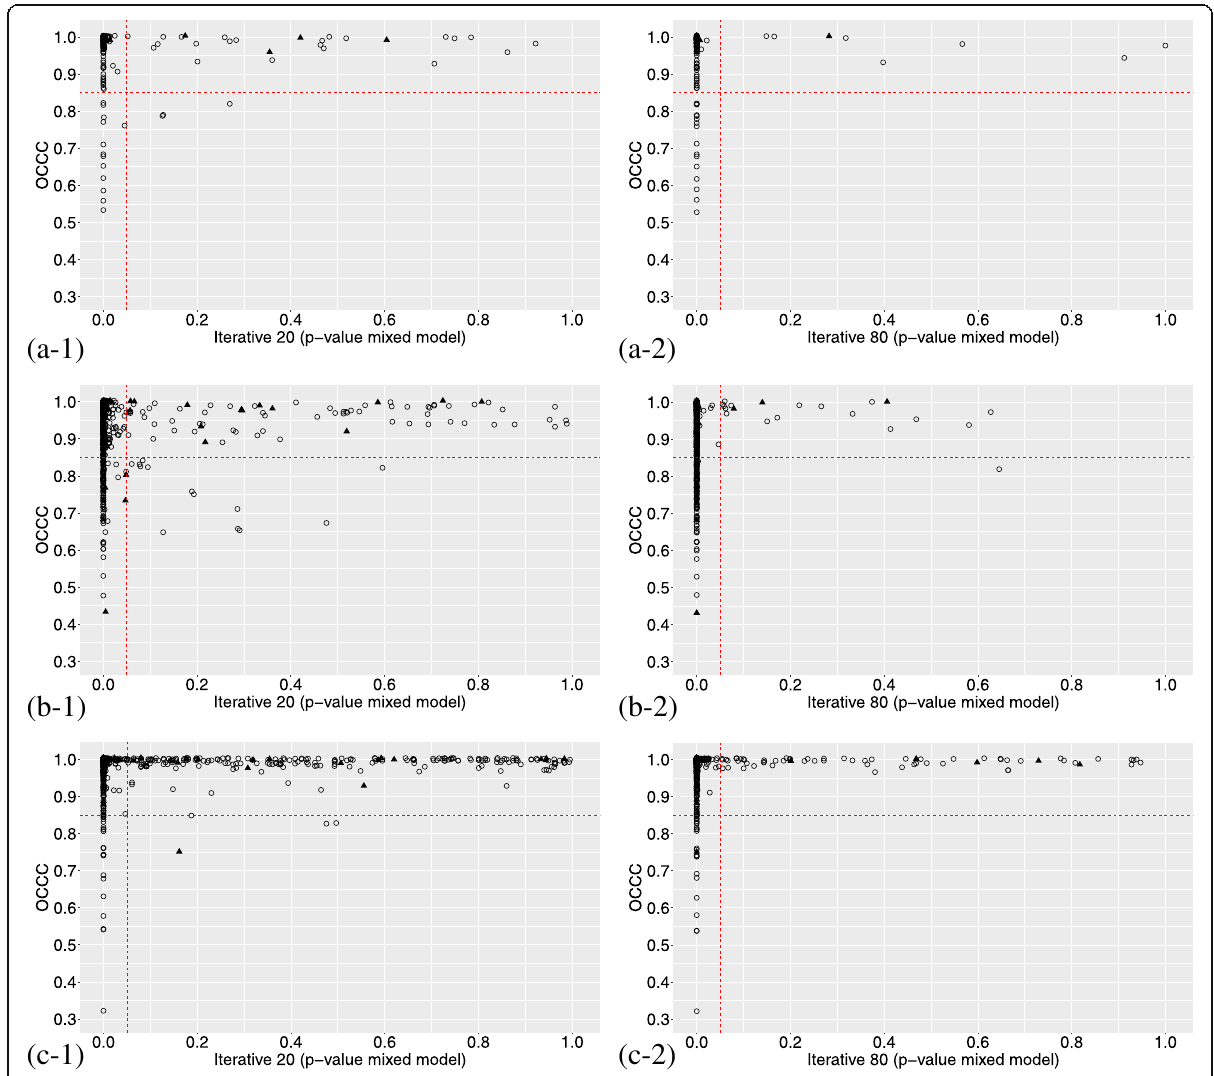
Fig. 4 Comparison between the overall concordance correlation coefficient (OCCC) and the p value from the multivariable mixed models for reconstruction algorithm analysis. The plots report two analysed cases of iterative reconstruction (IR20 and IR80), as an example, for original, Wavelet and LoG features: original- IR20 ( a-1 ), original-IR80 ( a-2 ), Wavelet-IR20 ( b-1 ), Wavelet-IR80 ( b-2 ), LoG-IR20 ( c-1 ) and LoG-IR80 ( c-2 ). The triangles indicate first order features, while the circles stand for texture features. The red dotted lines divide the plots in the four parts, according to the threshold chosen for OCCC and p value, equal to 0.85 and 0.05,